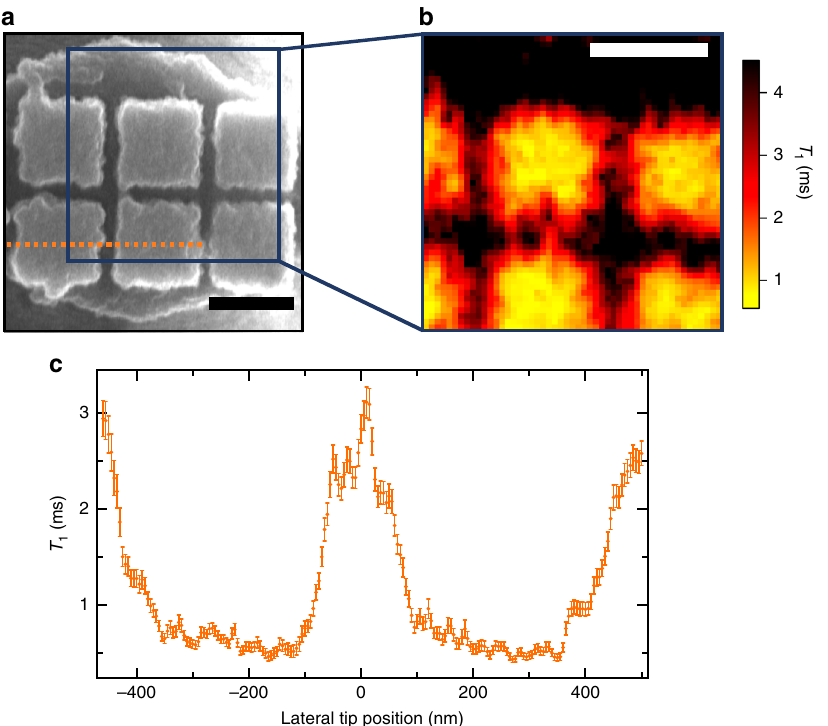
Fig. 3 Nanoscale conductivity imaging. a Scanning electron microscopy image of an Al nanopattern deposited onto an AFM tip, as depicted in Fig. 1a. b NV T μ m 2 blue square in ( a ), produced by scanning the NV center over this area at a height of 40 nm and with 20 nm pixel 1 image of the area depicted by the 1 spacing. c High-resolution T 1 line scan of the dotted orange line in ( a ). Features in the imaging plane are clearly resolved down to 5 nm, which is set by the point spacing in the scan. This line scan implements a spin-to-charge measurement sequence, which results in experimental measurement error only 5× the spin projection noise limit and signi fi cantly reduced imaging time: 25× faster than standard spin-dependent NV photoluminescence readout. The intrinsic T 1 is 6 ms for both NVs. Scale bars are 400 nm. Error-weighted, light smoothing is applied to the data in ( b ) and ( c ), for which nearest neighbors receive an additional weight reduction by a factor of 2.5. Error bars are calculated by propagating the measured standard error of the photoluminescence for the single- τ measurement of T 1